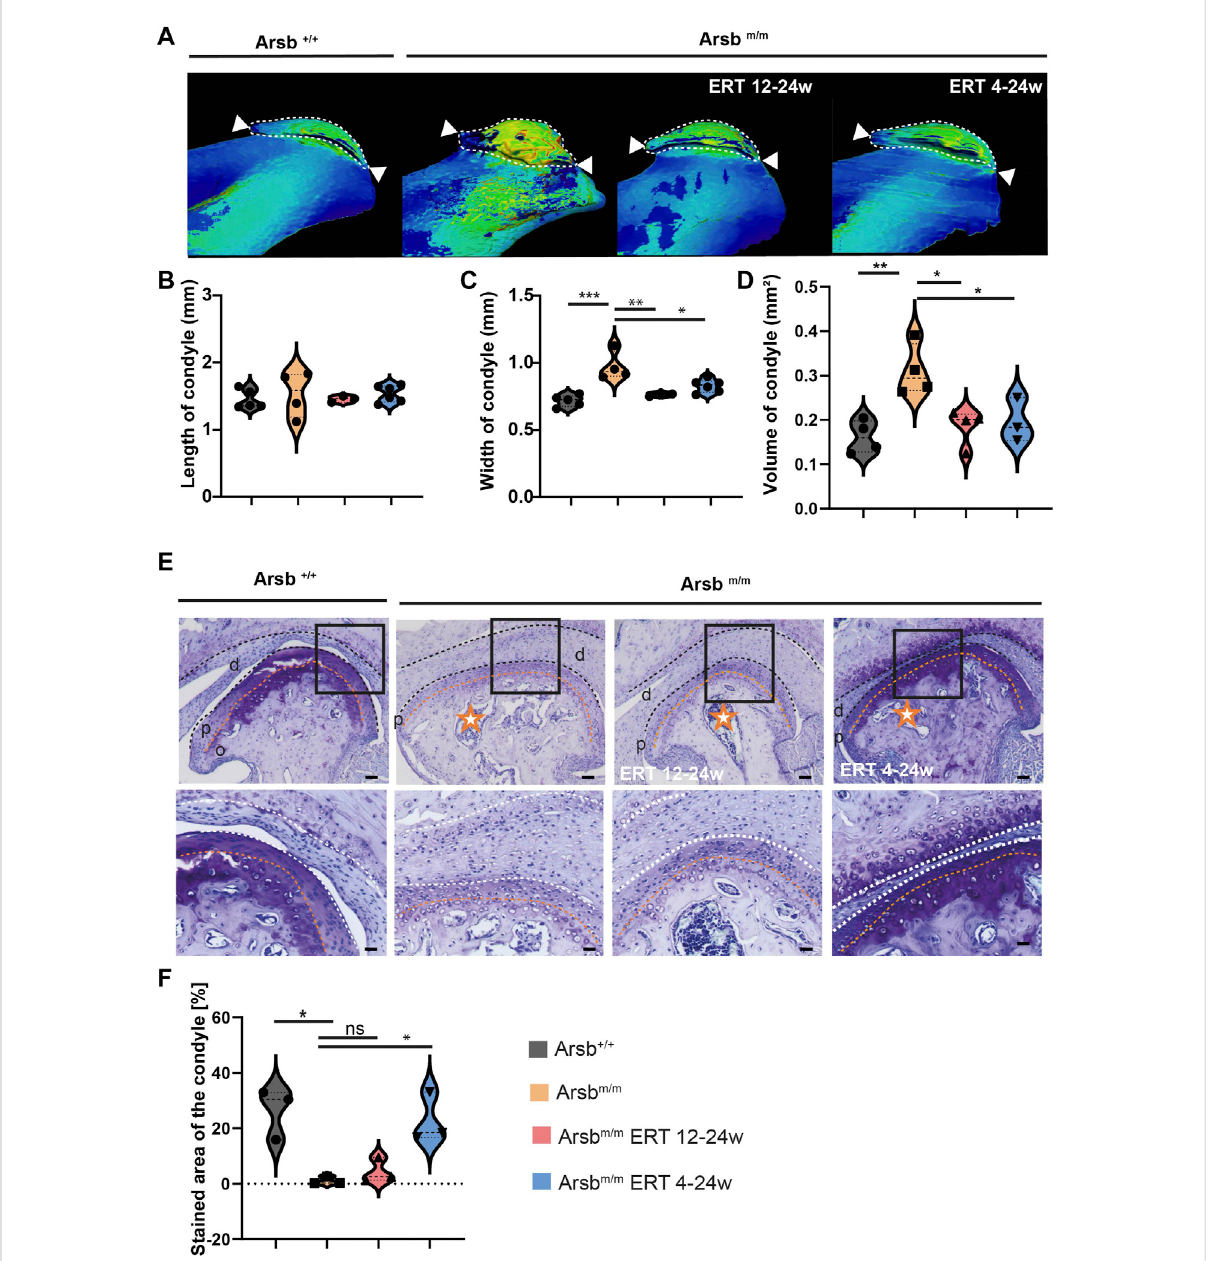
Dysmorphic condyle in Arsb m/m mice and Arsb m/m mice with ERT from 12 weeks of age. (A) 3D segmentation and wall thickness analysis of micro-CT scansofthecondyle of24-weekscontrol, Arsb m/m -mice, Arsb m/m -mice withERTfrom12 – 24 weeks,andERTfrom4 – 24 weeks. Arsb m/m -mice and Arsb m/m -mice with ERT from 12 weeks show bone exostoses and deformative pathologies of the mandibular condyle. Scale bar = 100 µm. (B) Quanti fi cation of condylar length. (C) Quanti fi cation of condylar width. (D) Quanti fi cation of condyle volume (E) Toluidine blue stainingshowingintensepigmentationofcartilagerevealingphysiologicalproteoglycanlevelsincontroland Arsb m/m micewithERTfrom4 weeks.In contrast, Arsb m/m mice without therapyand ERTshow faded staining from12 weeks.Middlepanel: Athigher magni fi cation, Arsb m/m mice show bone porosity(orangestars)andapathologicalcondyleshape.Inaddition,thecartilage-bonelinein Arsb m/m miceisirregularlyshapedandmarkedwithan orange dashed line. Lower panel: The super fi cial chondrocytes in the condyles and the chondrocytes in the articular disc of control mice show physiological size and shape (green arrows). Chondrocytes in Arsb m/m mice appear markedly hypertrophic, including vacuolization (orange arrows). In contrast, Arsb m/m mice treated with ERT from week four onwards have fewer hypertrophic chondrocytes (green arrows), almost equal to those of control mice. Scale bars = 100, 50, and 25 µm (from top to bottom). d = discus articularis, p = proliferating zone, o = sclerosing zone (F) Quanti fi cation of toluidine blue-stained area within the condyle * p < 0.05. ** p < 0.01. *** p <